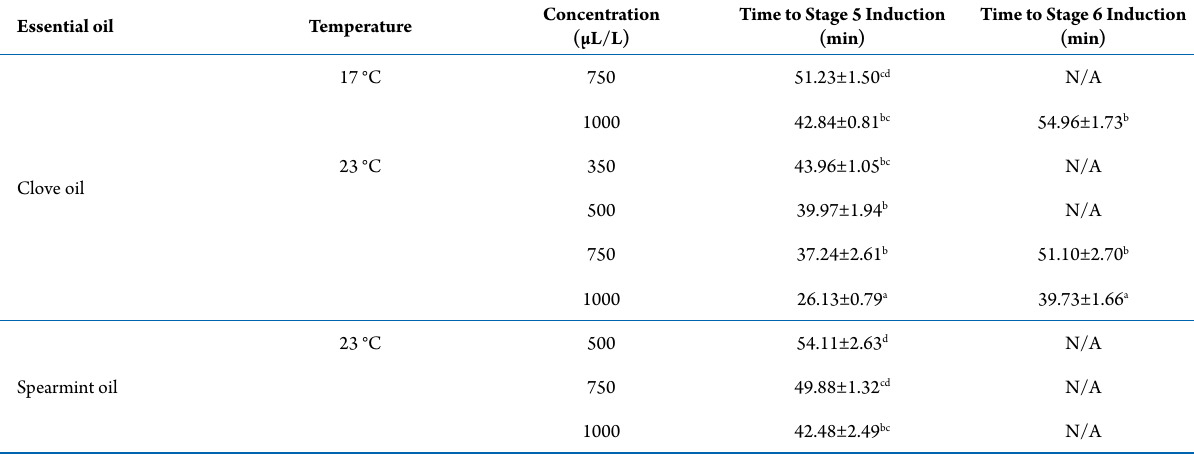
Table 2. Induction times to Stage 5 and Stage 6 from Stage 1 of red swamp crayfish exposed to different concentrations of clove and spearmint oils at two temperatures